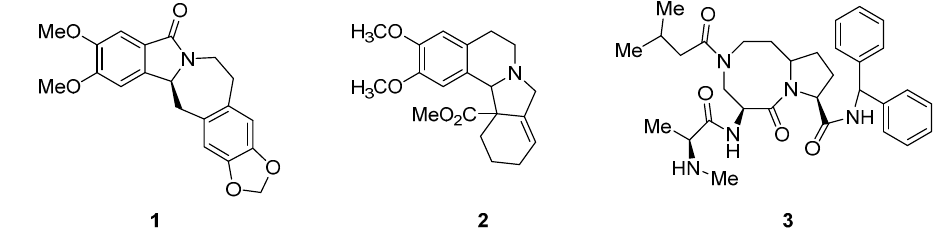
Figure 1. Biologically active isoindoles and fused diazocines 1 – 3 .